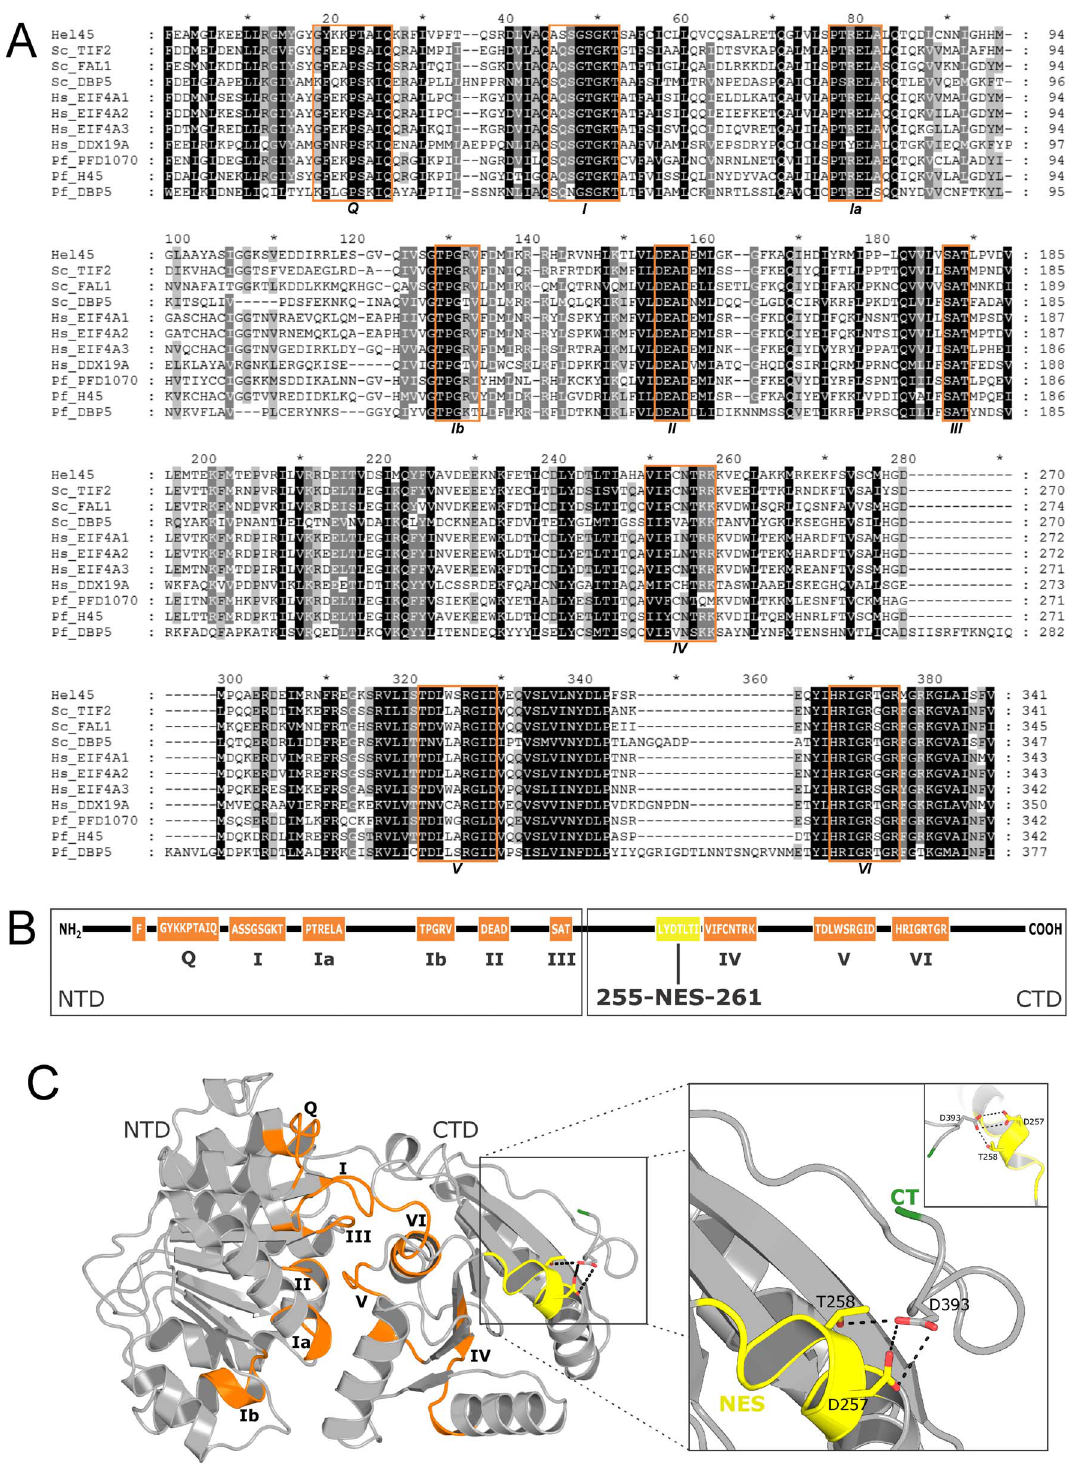
Figure 1. Multiple sequence alignment and prediction of the structure of Hel45. (A) Multiple sequence alignment of the diagnostic conserved region of the DEAD-box helicase family (positions 25–365 according to Hel45). The nine putative conserved motifs ( Q , I (WalkerA), Ia, Ib, II (WalkerB), III, IV, V, VI ) are marked with orange boxes. Alignment columns displaying 100%, more than 90%, and more than 80% of similarity are highlighted in black, dark grey, and light grey, respectively. Sequences are identified with organism abbreviation and gene name, except Hel45. The organism abbreviations are: Sc: Saccharomyces cerevisiae , Hs: Homo sapiens , Pf: Plasmodium falciparum . The sequences have the following GenBank Identifiers (GIs): Hel45 (71418343), Sc_TIF2 (6322323), Sc_FAL1 (398365053), Sc_DBP5 (6324620), Hs_EIF4A1 (4503529), Hs_EIF4A2 (83700235), Hs_EIF4A3 (7661920), Hs_DDX19A (8922886), Pf_PFD1070w (124505577), Pf_H45 (124810293), Pf_DBP5 (6324620). (B) Schematic representation showing the nine conserved helicase motifs are boxed in orange. The N-terminal domain (NTD) contains the motifs Q, I and II for ATP-binding, Ia and